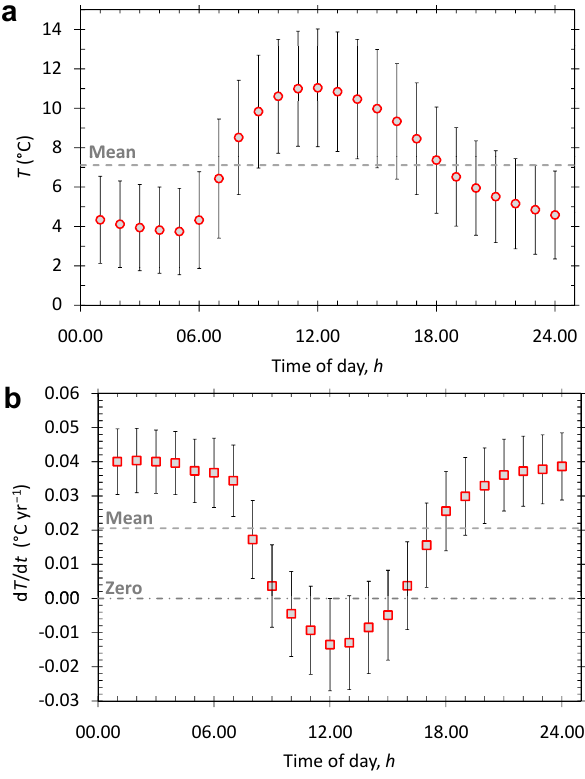
Fig. 2. Mean temperatures and best-fit trend-line slopes for the 30- yr Mauna Loa Observatory, Hawaii data (NOAA, 2009), as a func- tion of time of day (LST). (a) The mean of all hourly temperatures, T , at a specified time of day, h , for 1977–2006 (circles) with error bars ± 1s.d. of hourly values at time h for this period. The mean of the time-of-day values is T =7.11 ◦ C (dashed line). (b) Annual mean rates of warming (cooling) d T /d t (squares) are given as a function of time of day, h (error bars ± 1s.e. of the slope). The values at 12:00LST and 24:00LST are the slopes of the trend lines given in Fig. 1. The mean rate of warming (upper dashed line) for all hours is d T /d t =0.021 ± 0.011 ◦ Cyr − 1 ( ± mean of error bars in Fig.